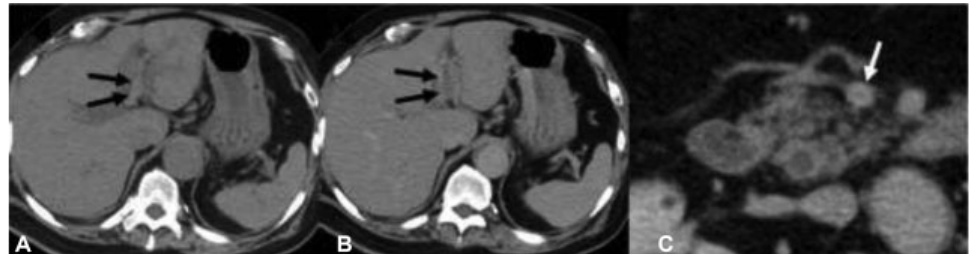
Fig. 1 Computed tomography (CT) showing thrombus ( arrows ) in the left branch of the intrahepatic portal vein ( A , noncontrast and B , contrast images) as well as in the superior mesenteric vein ( C , contrast image).